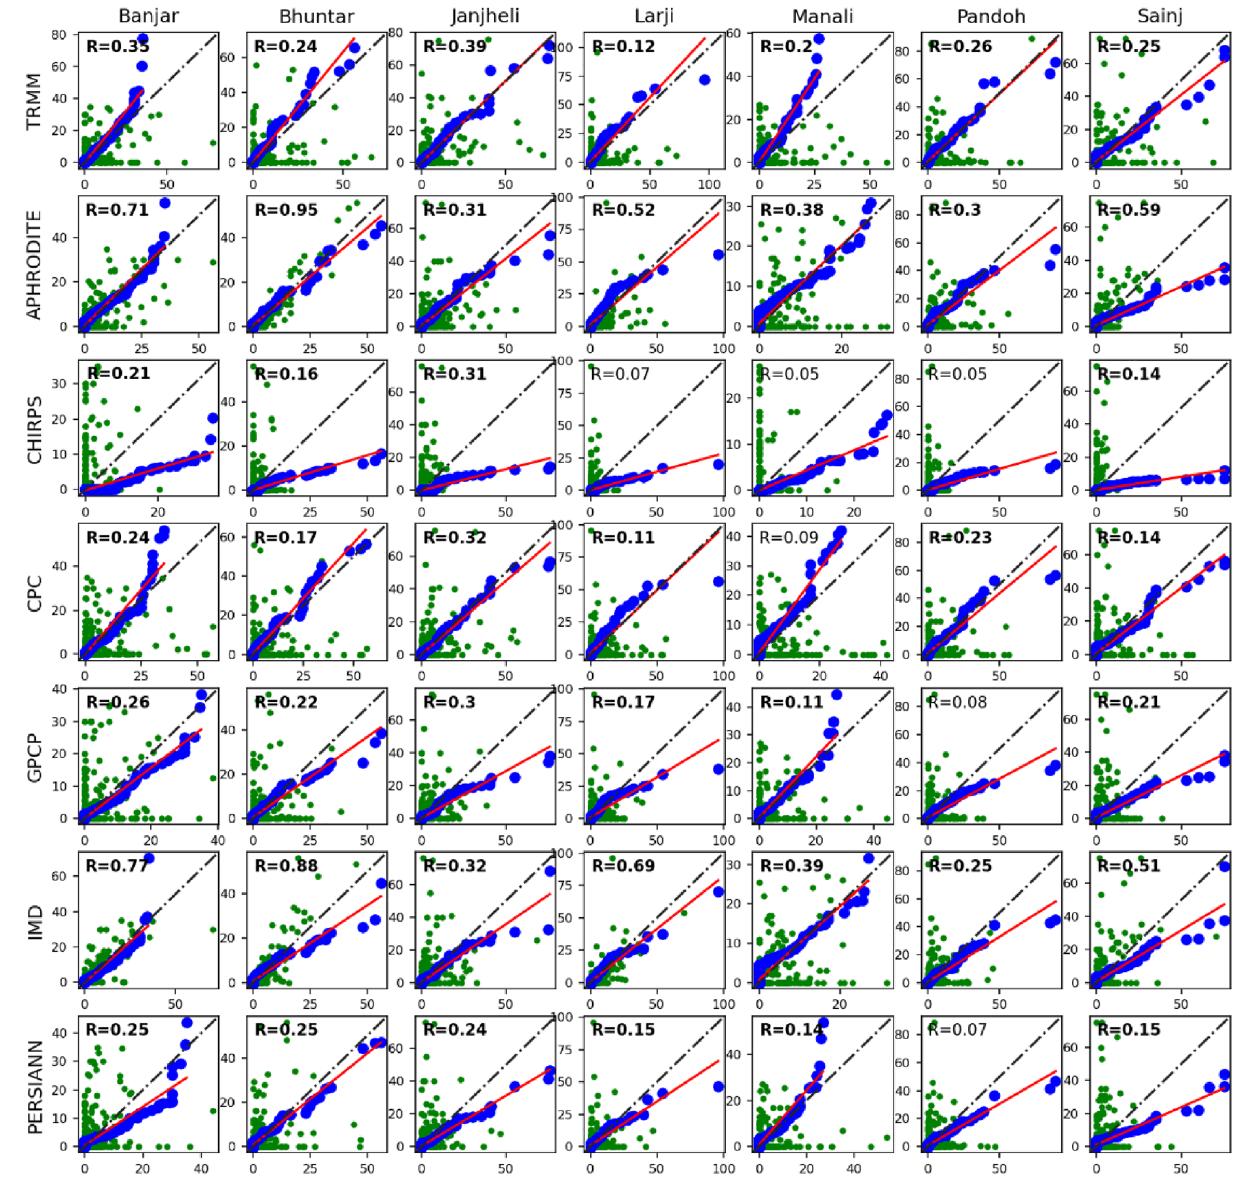
Figure 3. Quantile–Quantile plot (Q–Q plot) between WRF simulated precipitation and APHRODITE for 2003. WRF simulated experiments (WSM6_KF, WSM6_BMJ, MP8_KF, MP8_BMJ, MP3_KF, and MP3_BMJ) are plotted against Aphrodite precipitation for ANN ( a ), DJF ( b ), and JJAS ( c ). The blue dots are quantile to quantile plot, whereas green dots are scatter plot. Red line is the regression line corresponding to the quantile– quantile plot. Black line is the reference